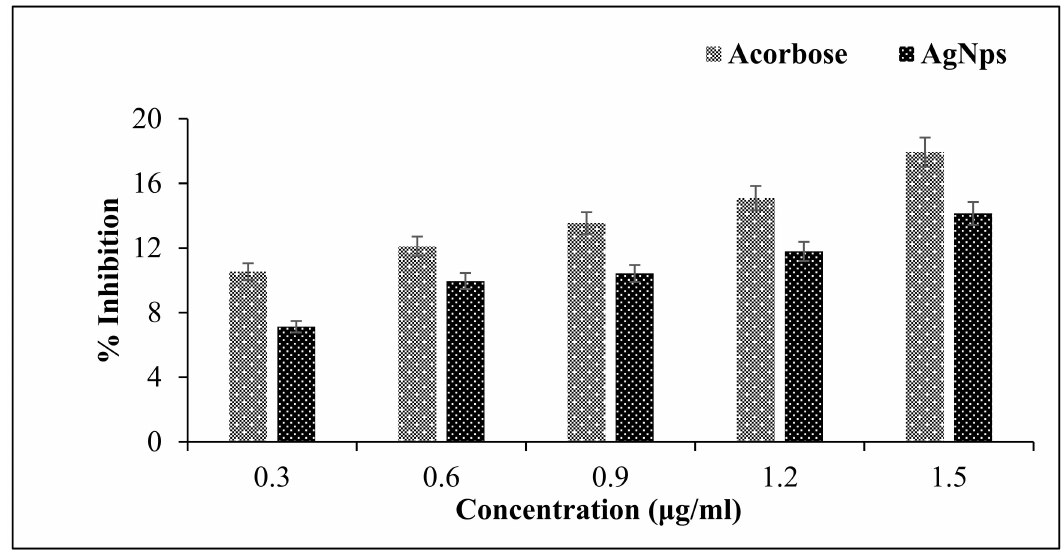
Figure 10. α -amylase activity of